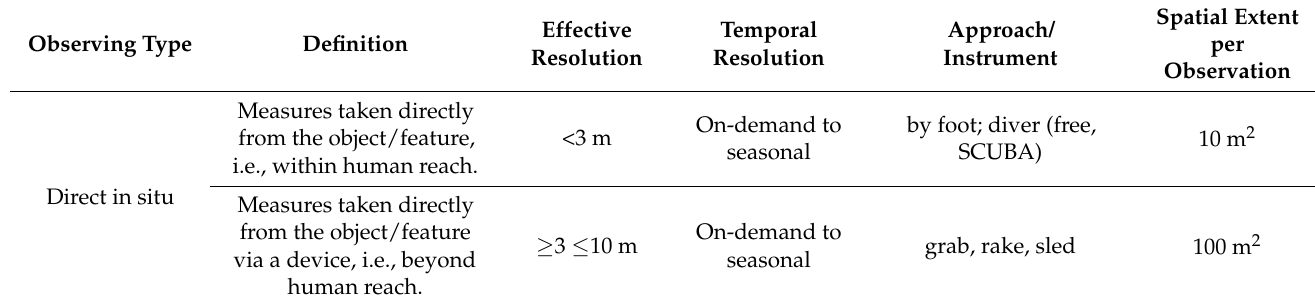
Table 3. Earth observing elements including type and data capture approach. Effective resolution is the size of the smallest feature that is discernible. Spatial extent per observation refers to maximum resolvable area represented by a single